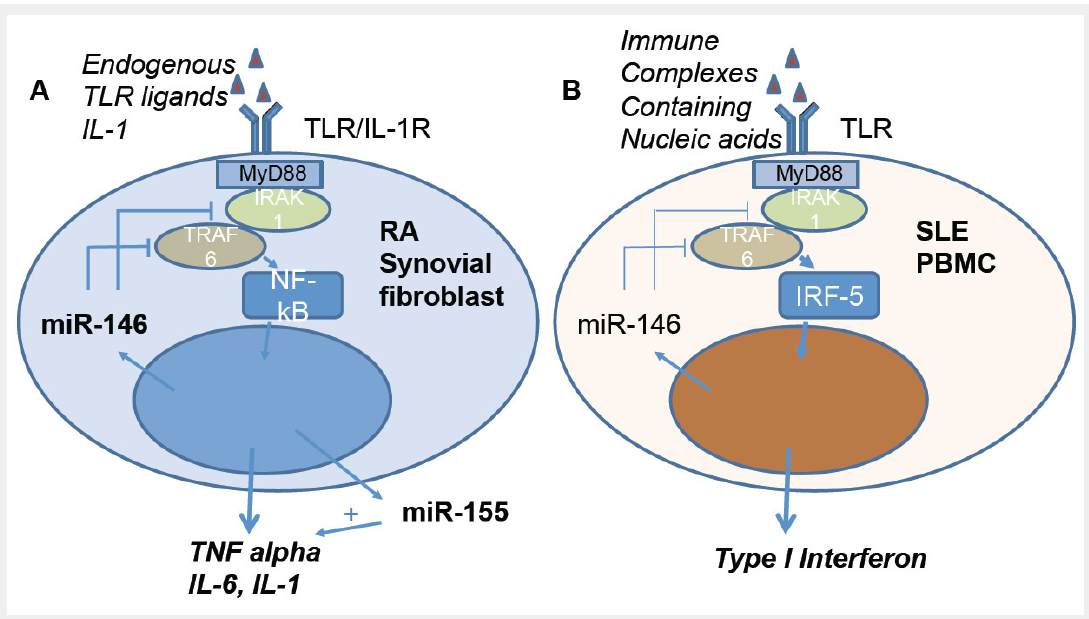
Figure 3: Regulatory role of miR-146 and miR-155 on inflammation in activated synovial fibroblasts of patients with rheumatoid arthritis (A) and on type I interferon production in PBMC of patients with SLE (B). (A) Activation of synovial fibroblasts by endogenous Toll-like receptor (TLR) ligands or interleukin 1 (IL-1) initiates a signalling cascade via nuclear factor kappa B (NF-κB) resulting in expression of proinflammatory cytokines, such as tumour necrosis factor alpha (TNF-α). Overexpression of TNF-α is a hallmark of rheumatoid arthritis. In activated synovial fibroblasts miR-155 expression is induced, further enhancing TNF-α production. In contrast, miR-146 has a modulatory role by inhibiting the signalling molecules interleukin 1 associated receptor kinase 1 (IRAK1) and TNF-receptor accessory factor 6 (TRAF 6). (B) Regulatory role of miR-146 in SLE PBMC. In contrast to the overexpression of miR-146 in RA, in SLE miR-146 levels are decreased, resulting in an increased activation of IRF-5 and expression of type 1 interferon. IRF-5 = interferon regulatory factor 5; PBMC = peripheral blood mononuclear cells; RA = rheumatoid arthritis; SLE = systemic lupus